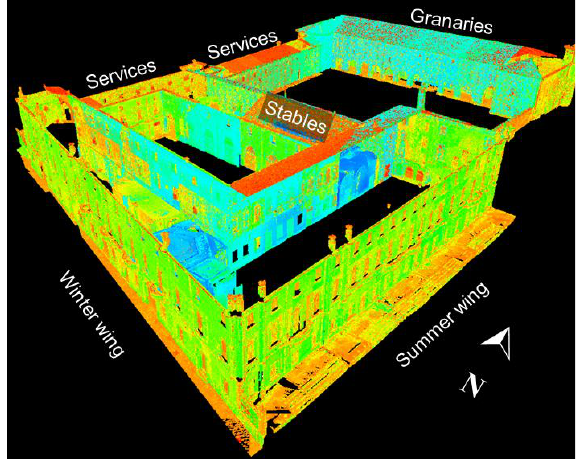
Figure 15: View of the global point cloud of the Villa